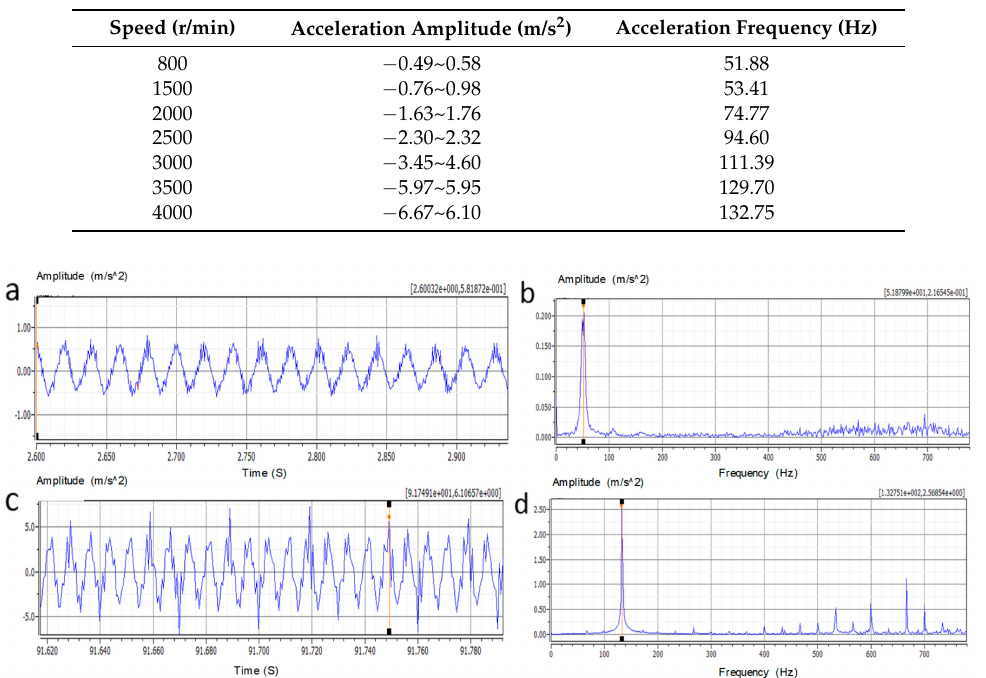
Table 1. The eigenvalues of vibration signal in Z direction on the cylinder head of the 2HO engine.